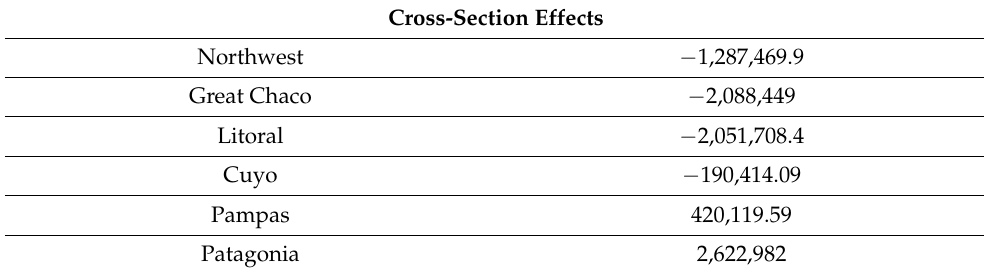
Table 6. Cross-section effects for Argentinians